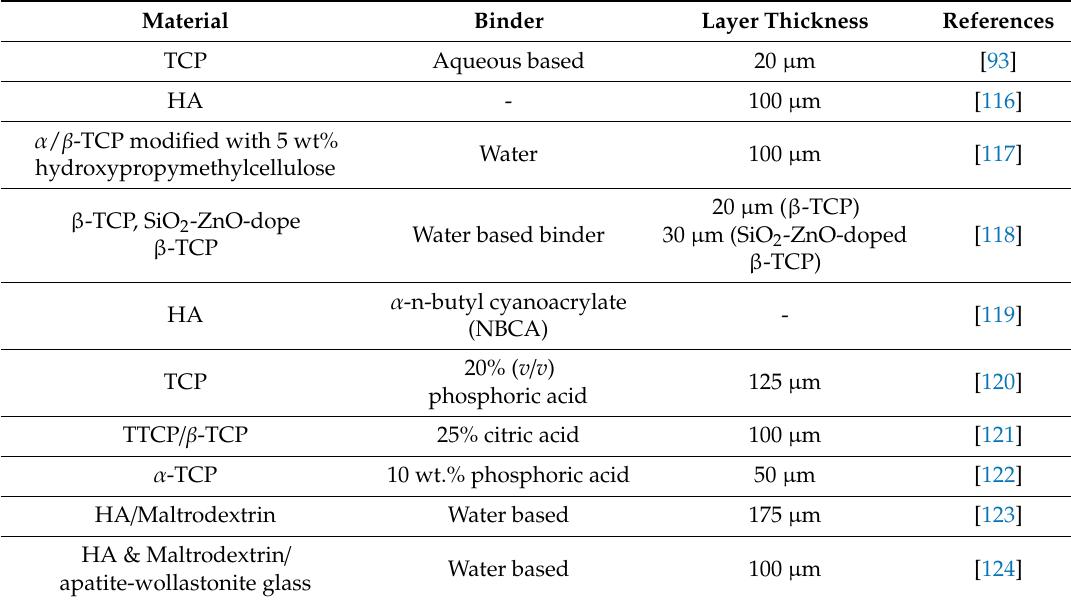
Table 5. Additive manufacturing (AM) materials for bone